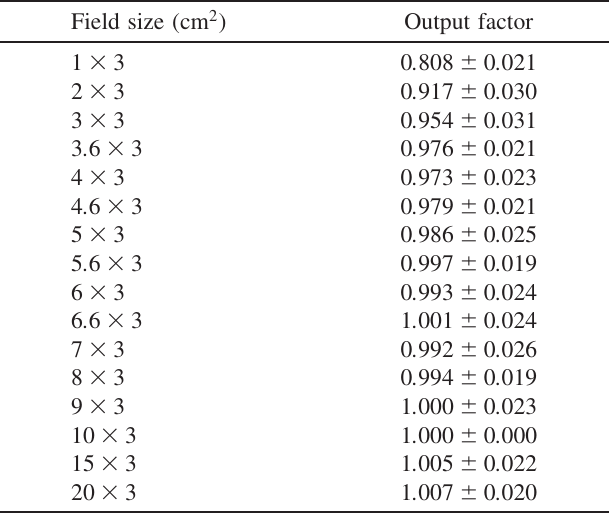
TABLE III. Output factor in the slab phantom given by rect- angular fields. These data are represented in Fig.